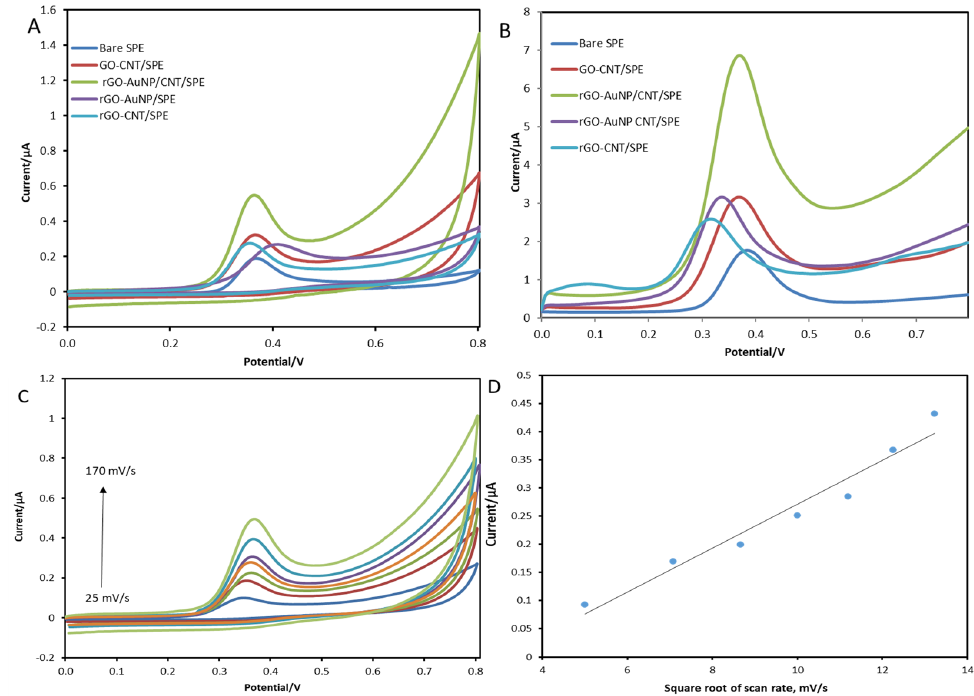
Figure 5. ( A ) Cyclic voltammograms (CVs) of the bare SPE, GO-CNT/SPE, rGO-AuNPs/CNT/SPE, rGO-AuNPs/SPE, and rGO-CNT/SPE in 20 µM E2 at 100 mVs −1 . ( B ) Differential pulse voltammo- grams (DPVs) of the bare SPE, GO-CNT/SPE, rGO-AuNPs/CNT/SPE, rGO-AuNPs/SPE, and rGO- CNT/SPE in 20 µM E2 in Brion–Robinson buffer (pH 5). ( C ) Cyclic voltammograms (CVs) of rGO- AuNPs/CNT/SPE in 20 µM E2 at a 25–170 mVs −1 scan rate. ( D ) Plot of current peak vs. square root of scan rate.